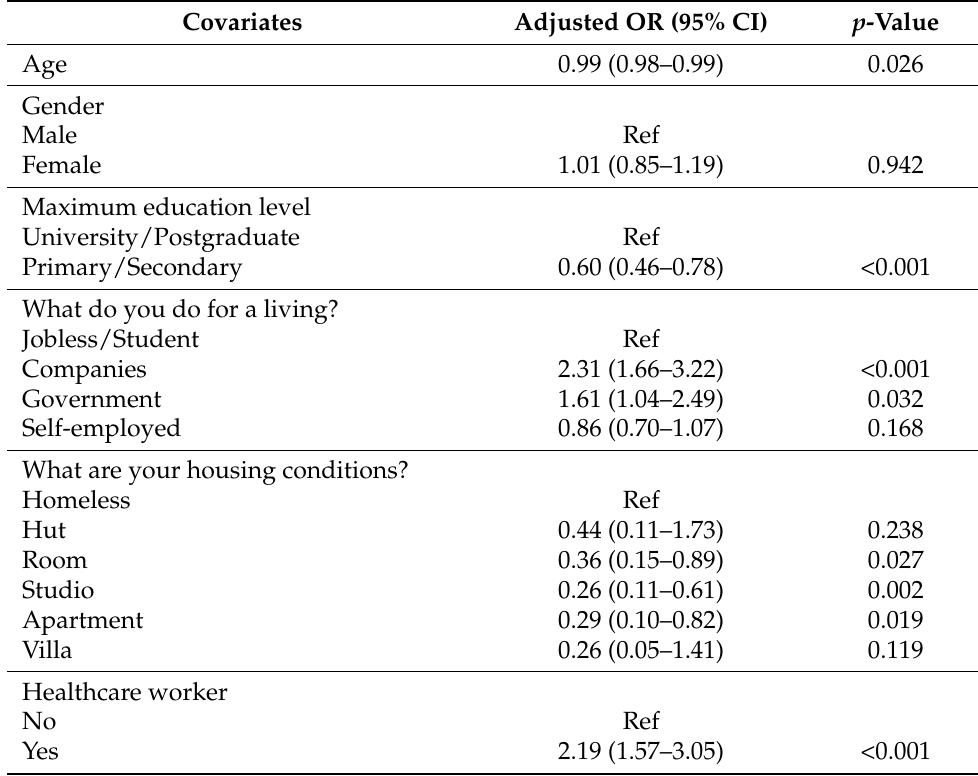
Table 6. Logistic Regression with Generalized Estimation Equations (GEE) estimation procedure for Composite Adherence score dichotomized as adherence (coded as 1) and non-adherence (coded as